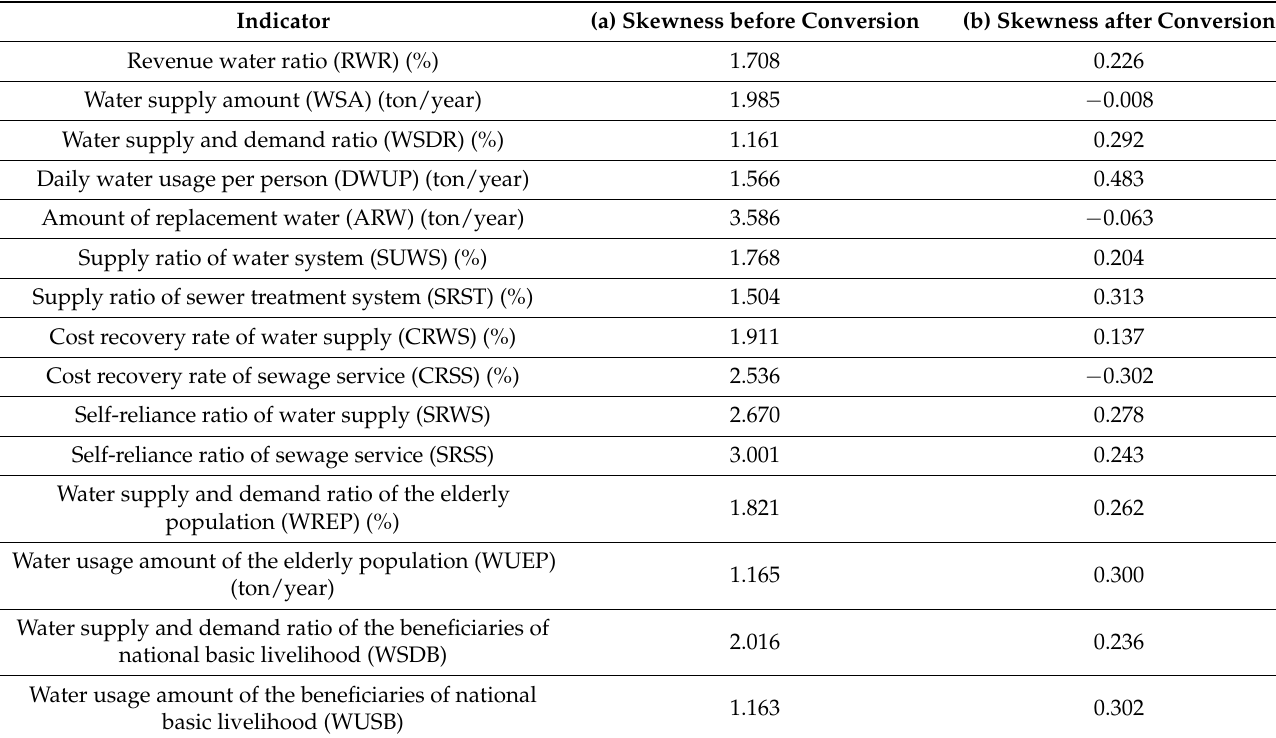
Table 4. Results of the indicators’